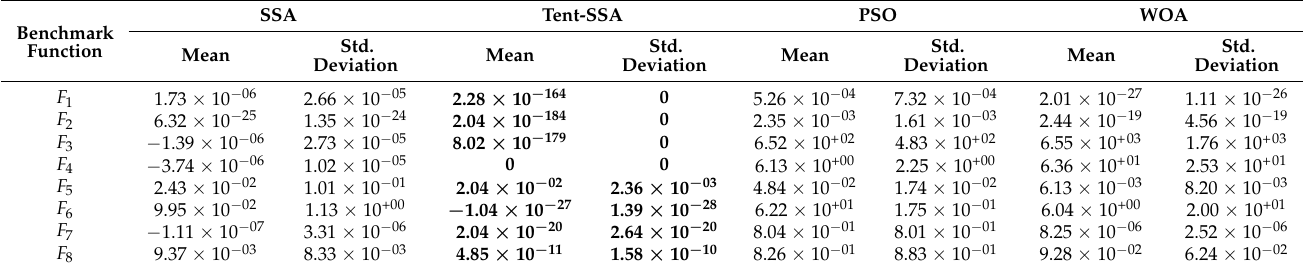
Figure 6. Iterative convergence curves for different test functions. ( a – h ) F 1 – F 8 iterative conver- gence curves. Table 3. Test function